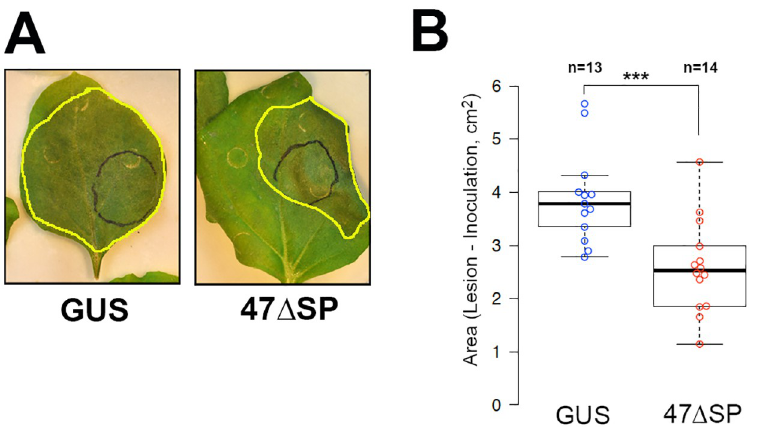
Fig 3. Pvit47 expression in N . benthamiana leaves reduces P . parasitica lesion size. Full N . benthamiana leaves were infiltrated with Agrobacterium strains carrying constructs for GUS (negative control) or Pvit47 Δ SP (47 Δ SP) and 2 days later P . parasitica was inoculated by infiltration of a spore suspension. (A) Representative images of leaves at 3 days post-inoculation (dpi). P . parasitica lesions are outlined in yellow and black circles indicate the area infiltrated with P . parasitica spores. (B) Quantification of lesion size at 3 dpi as necrotic area, excluding the inoculated area. The experiment was repeated a second time with similar results (S4 Fig). Asterisks show statistical significance of p < 0.001 ( ��� ) in a two-tailed T-test for mean